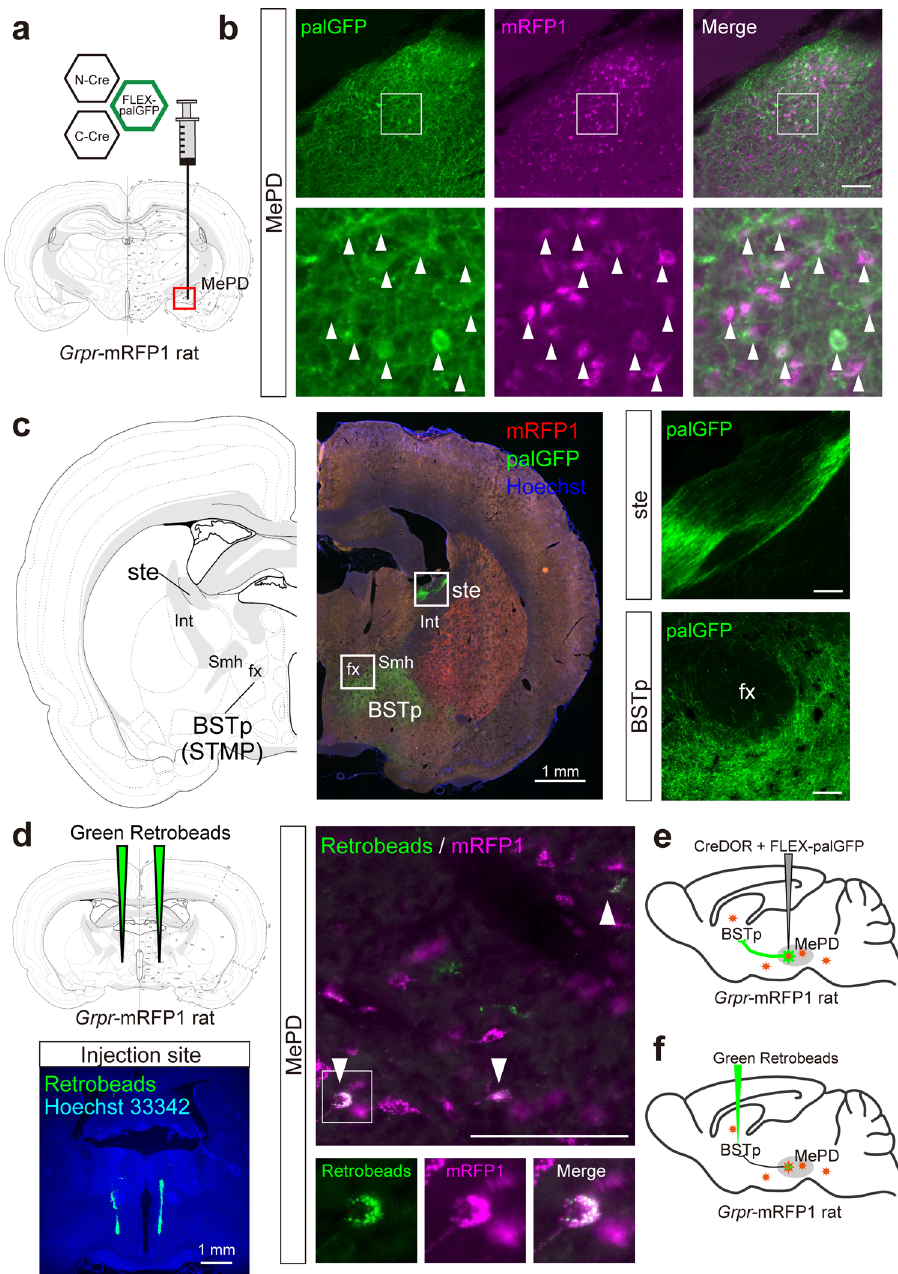
Fig. 6 Anterograde tracing using Cre-DOR in transgenic mRFP1-expressing rats. a Stereotaxic injection schema of Cre-DOR N6C1 in Grpr -mRFP1 transgenic rats. Three kinds of virus (NCre-MBP6, CCre-MBP1, FLEX-palGFP) were injected in the medial amygdala. b Immuno fl uorescent images of the MePD of injected rats. Scale bar = 100 μ m. c A representative image of axonal projection from palGFP-expressing neurons in the MePD of a Grpr -mRFP1 transgenic rat. Scale bar = 100 μ m or 1 mm. d Injection schema of green retrobeads in a Grpr -mRFP1 rat. Scale bar = 100 μ m or 1 mm. e Illustration of anterograde tracing using Cre-DOR in Grpr -mRFP1 rats. f Illustration of retrograde tracing using green retrobeads in Grpr -mRFP1 rats. All the rat brain atlas images were derived from Swanson, L.W. (2004) Brain maps: structure of the rat brain, 3rd edition (Creative Commons Attribution-NonCommercial